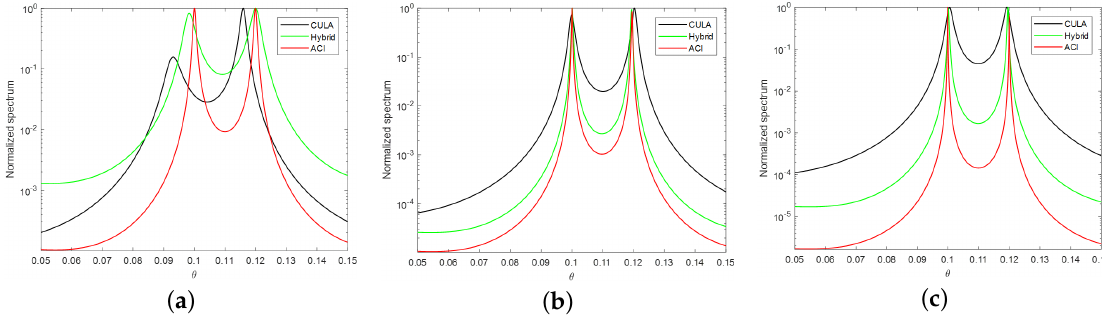
Figure 8. Angular Resolution of two close sources ( θ 1 = 0.10 and θ 2 = 0.12) with different scenarios ( a ) SNR = 0 dB, Snapshots = 100; ( b ) SNR = 5 dB, Snapshots = 200; ( c ) SNR = 10 dB, Snapshots =